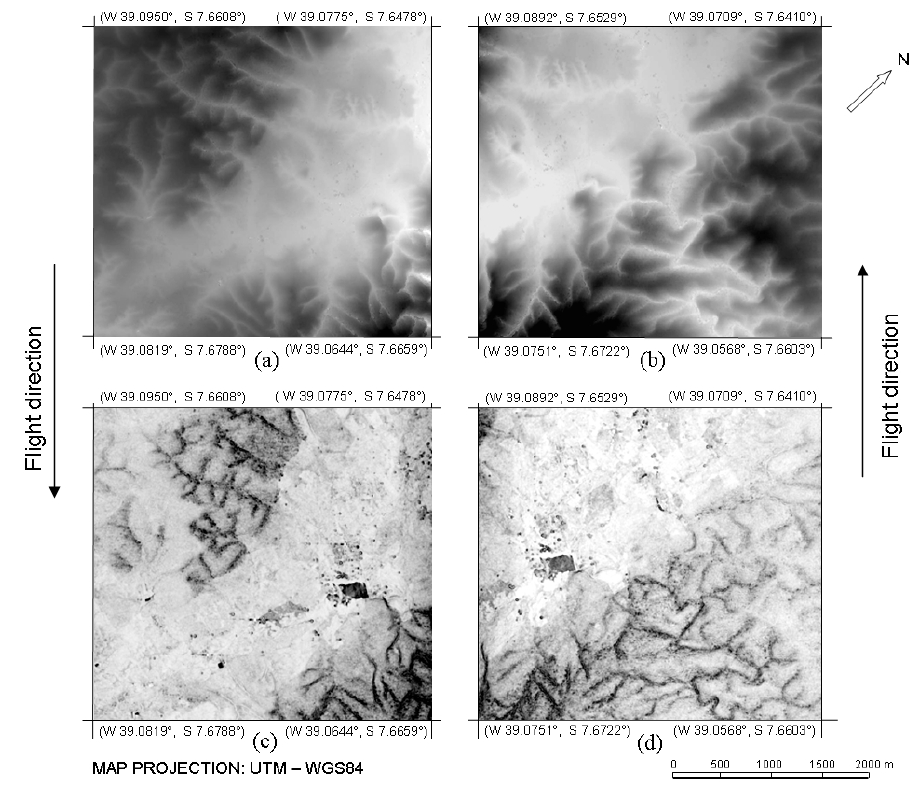
Figure 6. OrbiSAR-1 X-band InSAR data; ( a ) unwrapped phase grid and ( c ) coherence image of the first acquisition; ( b ) unwrapped phase grid and ( d ) coherence image of the second acquisition.